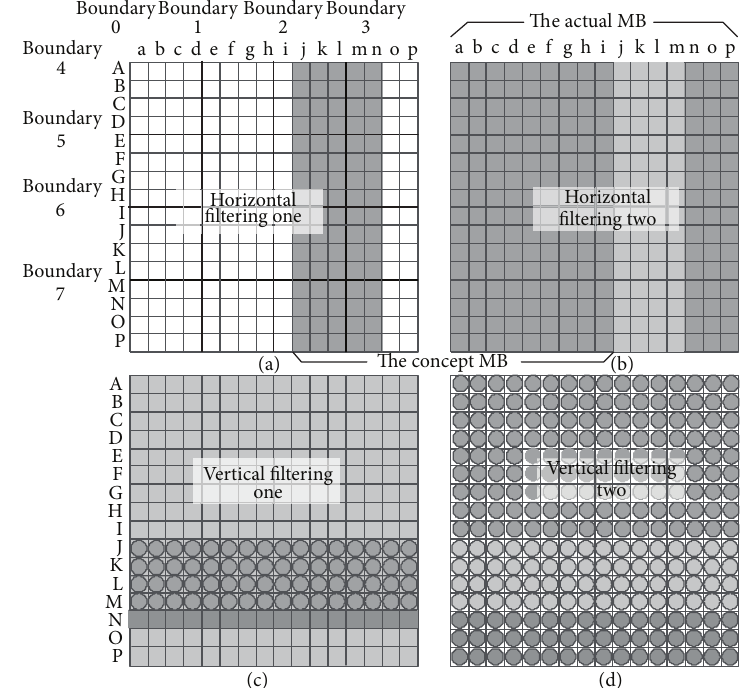
Figure 14: Scheduling of the filter for MB. White : original pixels; light gray : previously filtered pixels; dark gray : filtered in current pass; circled : pixels in their final state.